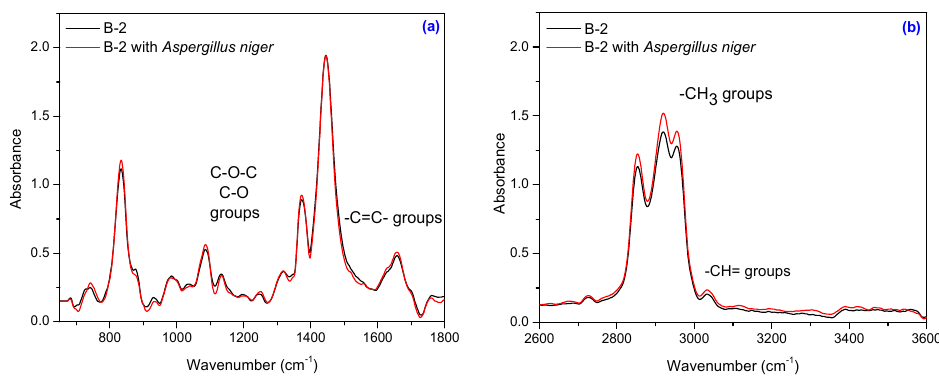
Figure 14. Infrared spectrum of the B-2 sample: ( a ) in the range of 650–1800 cm − 1 and ( b ) in the range of 2600–3600 cm − 1 .